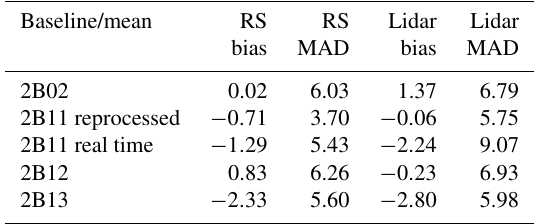
Table 3. Overview of the different characteristics (Bias and MAD) averaged (mean) for each instrument and baseline. The real-time and reprocessed data are also separated because of varying calibra- tion parameters. Baseline/mean RS RS Lidar Lidar bias MAD bias MAD 2B02 0.02 6.03 1.37 6.79 2B11 reprocessed − 0 . 71 3.70 − 0 . 06